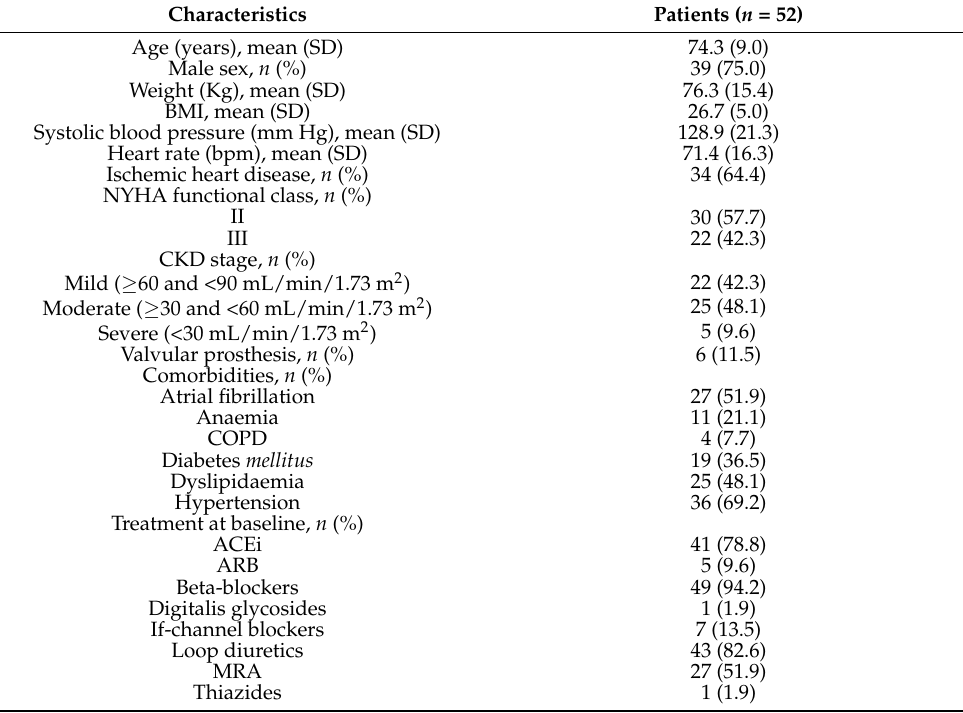
Table 1. Baseline characteristics of the overall study